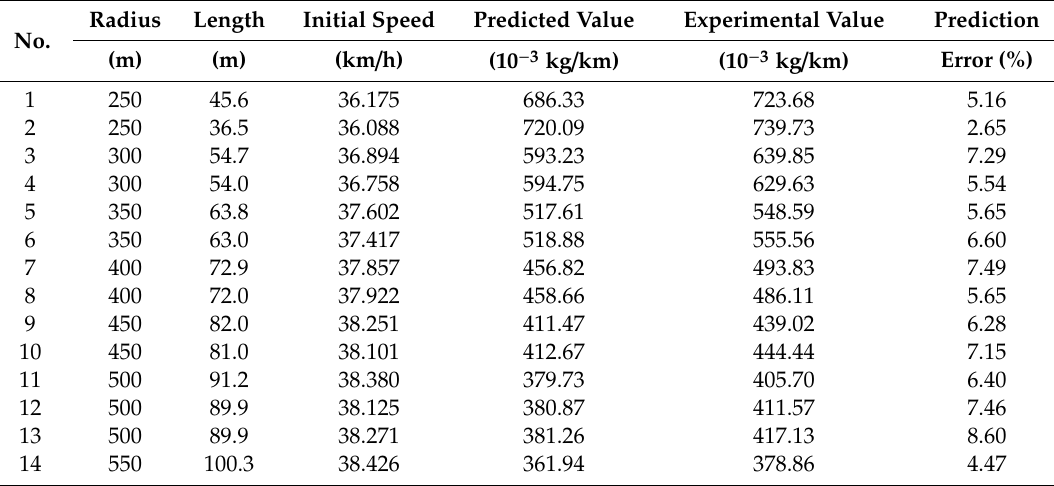
Table 14. Relative errors of predicted and experimental CO 2